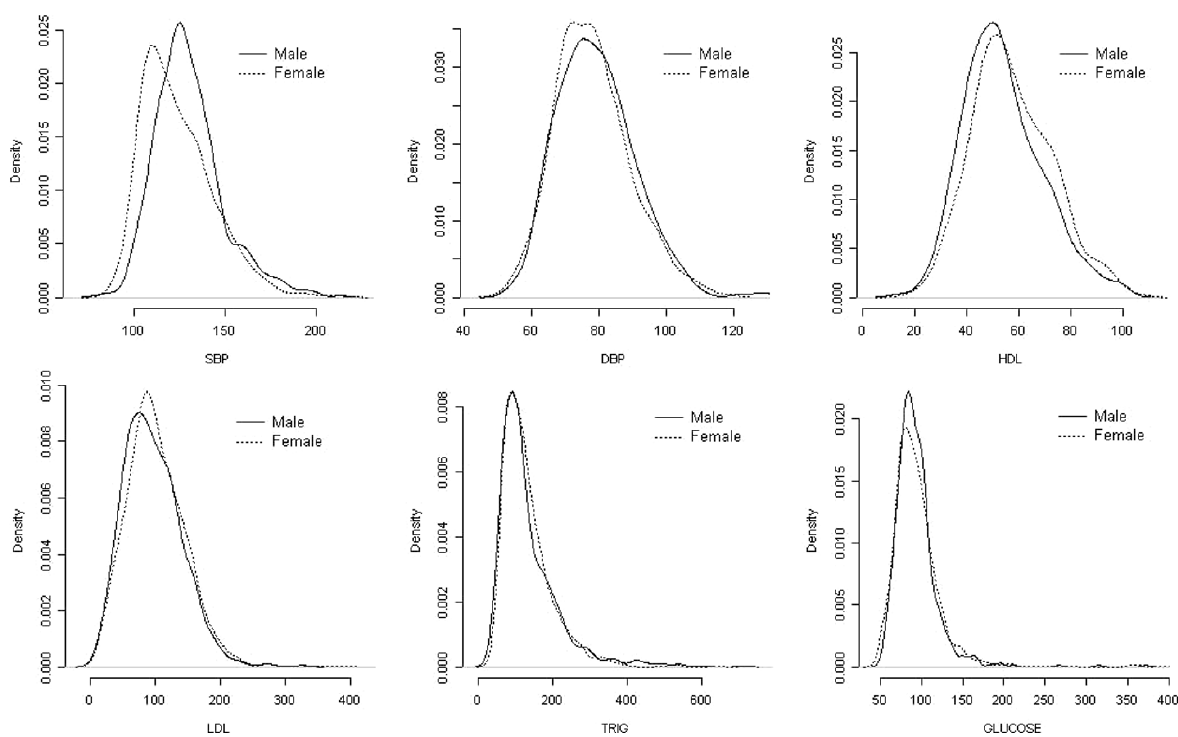
Figure 1 Distribution of six cardiovascular traits for males and females . Empirical densities are plotted for males (solid lines) and females (dashed lines) for systolic blood pressure (SBP), diastolic blood pressure (DPB), HDL-cholesterol, LDL-cholesterol, triglycerides (TRG), and fasting blood